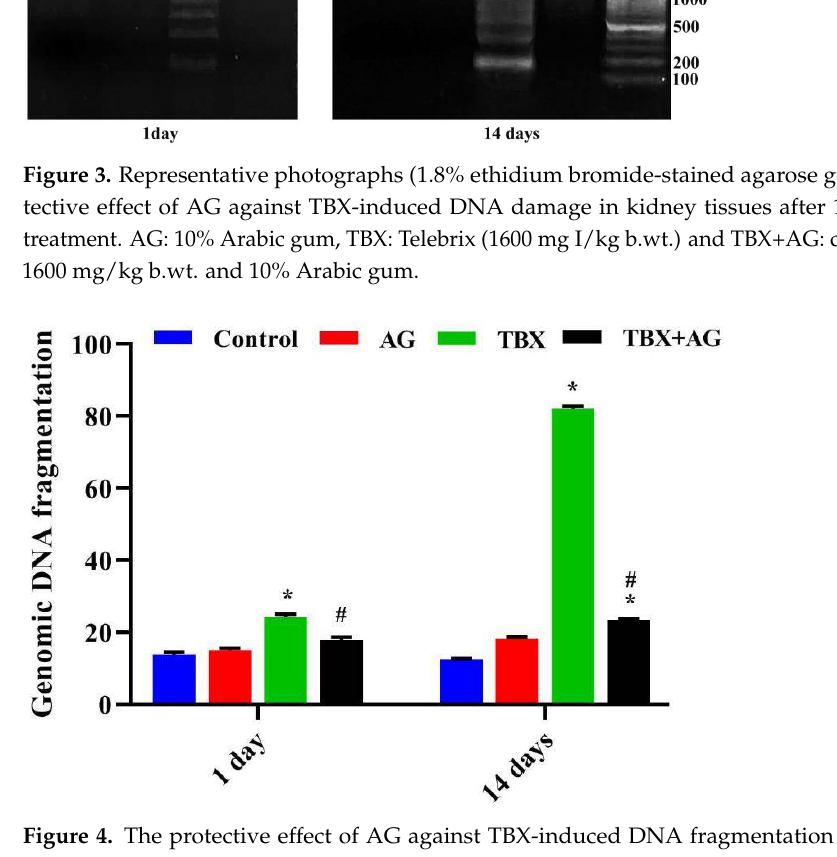
Figure 4. The protective effect of AG against TBX-induced DNA fragmentation employing 1.8% agarose gel electrophoresis of kidney tissues of treated rats after 1 and 14 days of treatments. *: Significant ( p < 0.001) relative to untreated groups. #: Significant ( p < 0.001) relative to TBX-treated groups. Data were represented as mean ± SE of three independent experiments ( n = 5). AG: 10% Arabic gum, TBX: Telebrix (1600 mg I/kg b.wt.) and TBX+AG: co-treatment with 1600 mg/kg b.wt. and 10% Arabic gum.